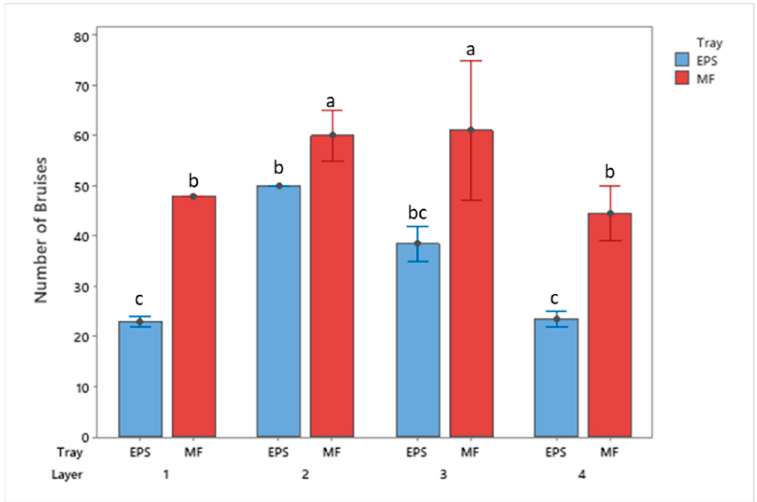
Figure 7. Bruise frequency of apples by tray location packaged using MF and EPS trays from 50 cm drop height (mean ± SD, n = 2). Different letters indicate statistically significant differences at p < 0.05. Bars with no common letters are significantly different ( p < 0.05).